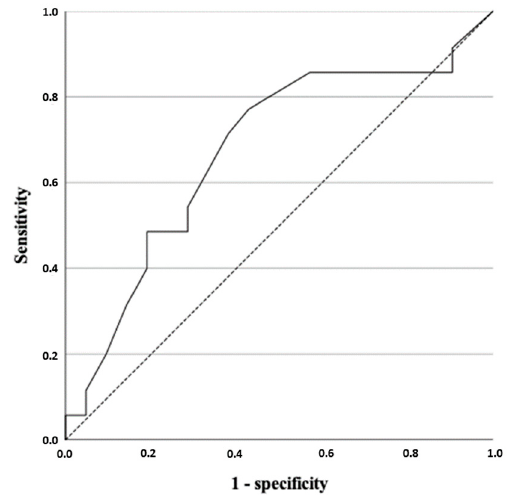
Figure 4. Receiver-operating characteristic curve for the strain ratio (semiquantitative analysis) taking intratumoral fibrosis as the reference ( p = 0.03).